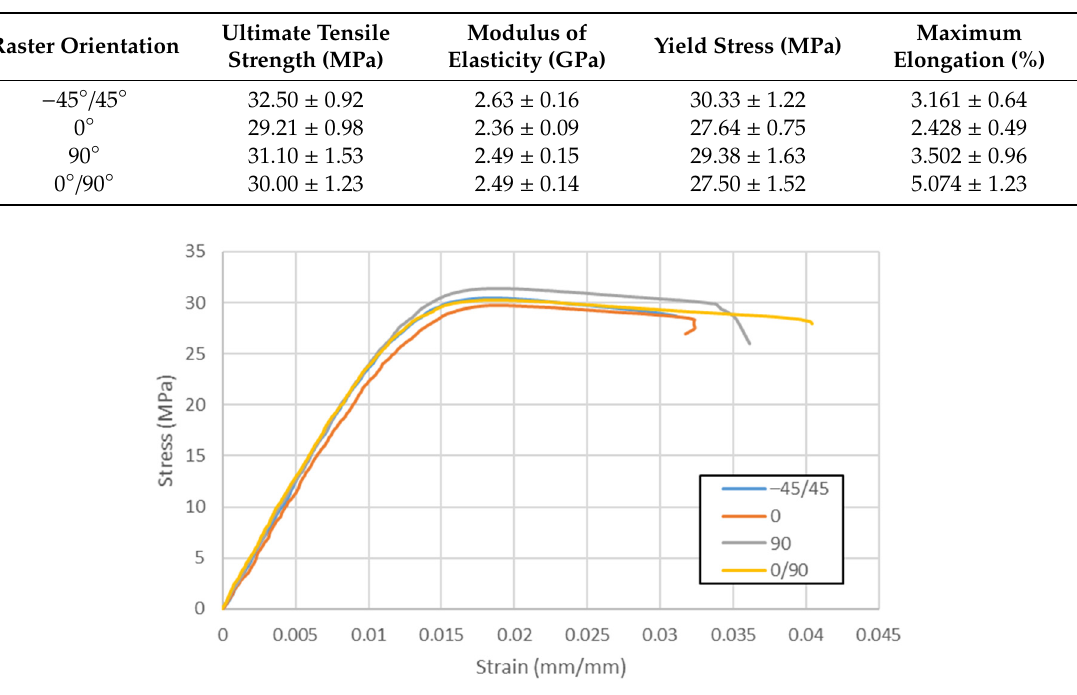
Table 3. Flexural Testing Results.